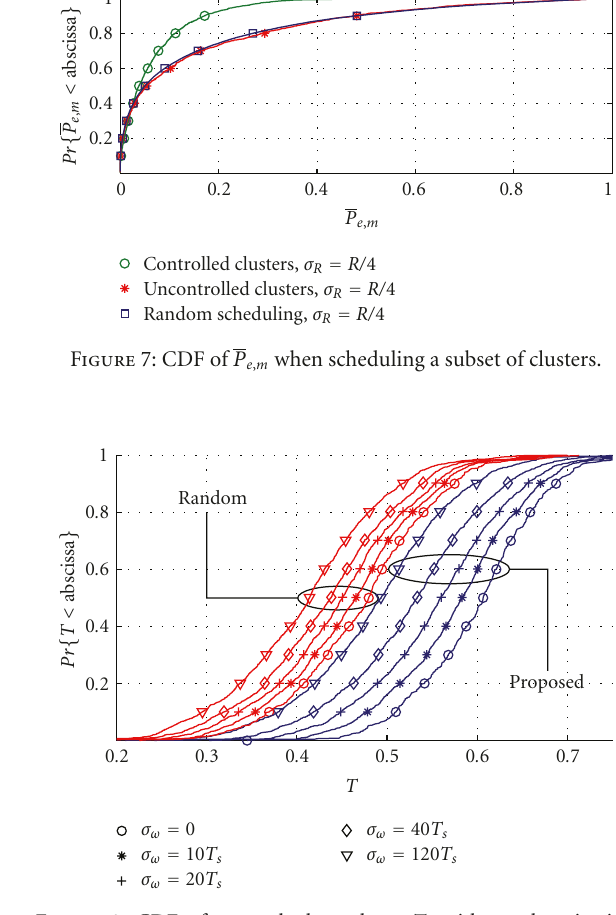
Figure 8: CDF of network throughput T , with synchronization